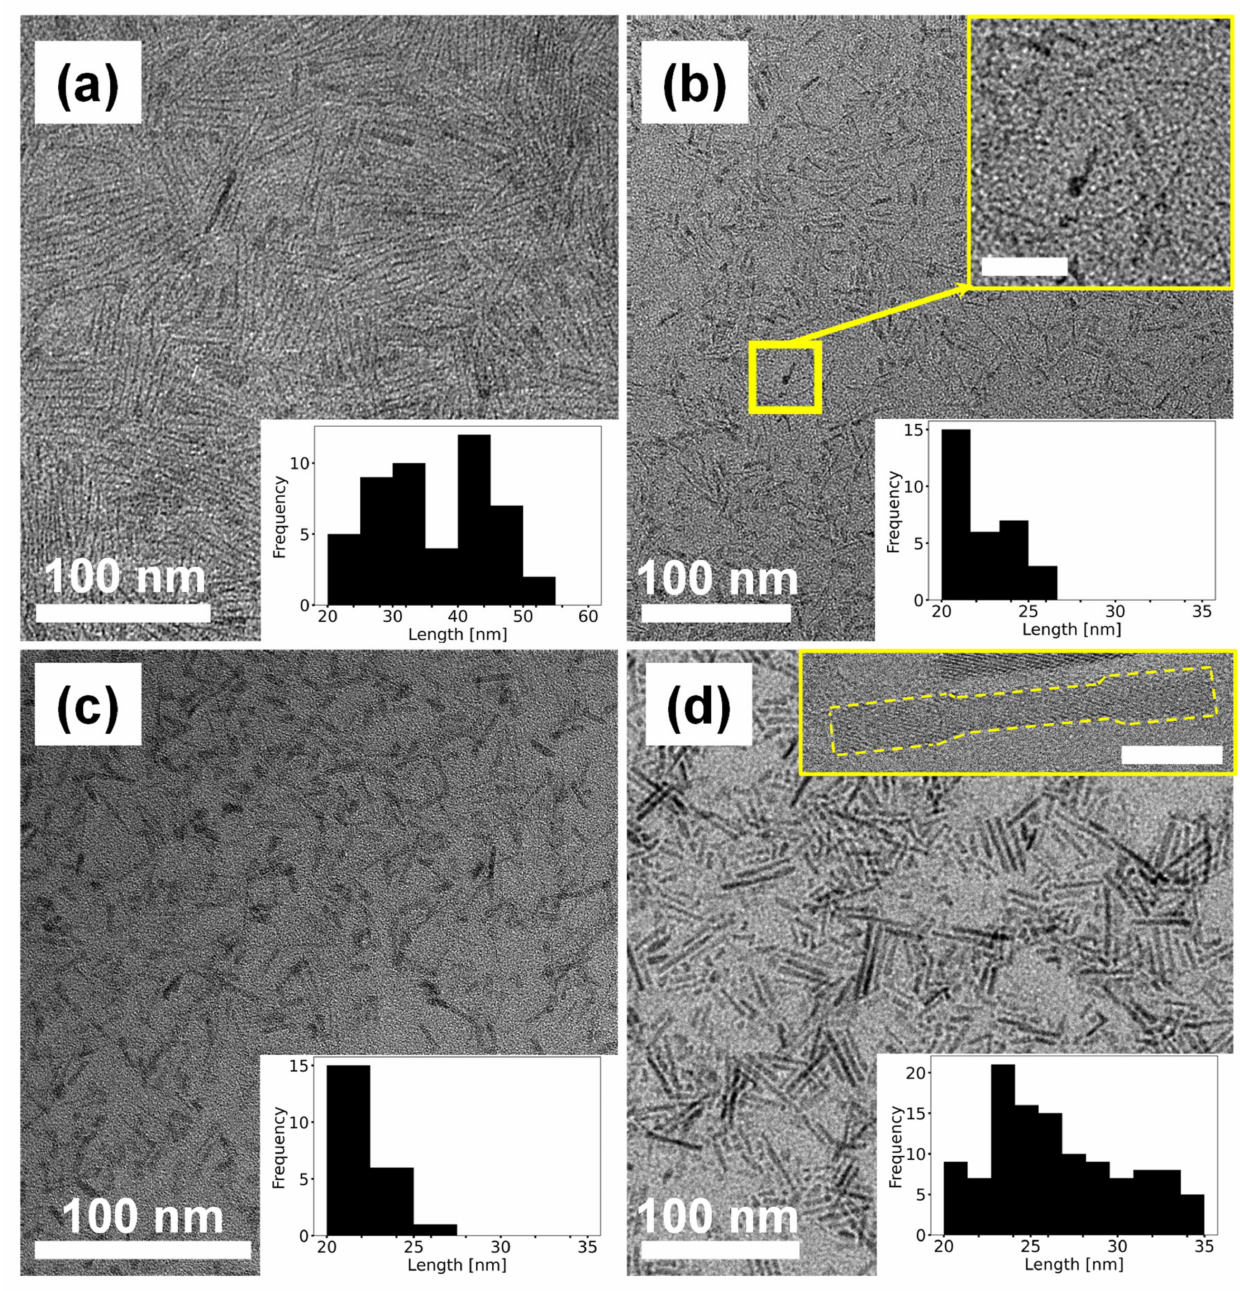
Figure 2. ( a – d ) TEM micrographs of TiO 2 NCs depicting progressive evolution of NCs at different time intervals (10 min, 20 min, 60 min, and 120 min, respectively) from ultrathin NRs to the final mixture of NRs of various lengths and semispherical NCs. The length distributions of TiO 2 are shown in histograms as insets with black columns. The average thickness of the NRs are 1.8 ± 0.3 nm in ( a ), 2.6 ± 0.5 nm in ( b ), 2.9 ± 0.7 nm in ( c ), and 3.6 ± 0.4 nm in ( d ). Inset in ( b ) shows the occurrence of irregularities at the tip of the NRs. Inset in ( d ) shows an HRTEM image of a single NR exhibiting a dumbbell shape at higher resolutions. Scale bar in b-inset is 25 nm and in d-inset is 5